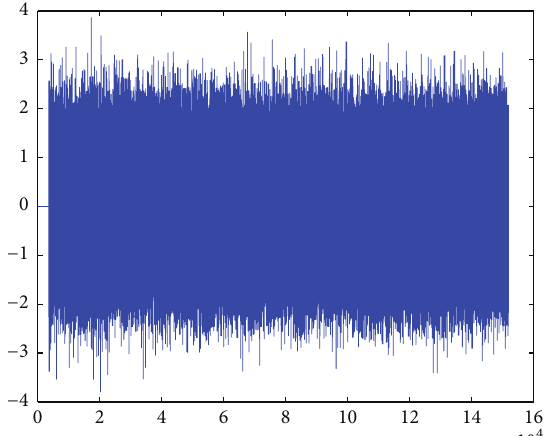
Figure 9: Temporal waveform of the DCT precoded and scaled QPSK OFDM signal.